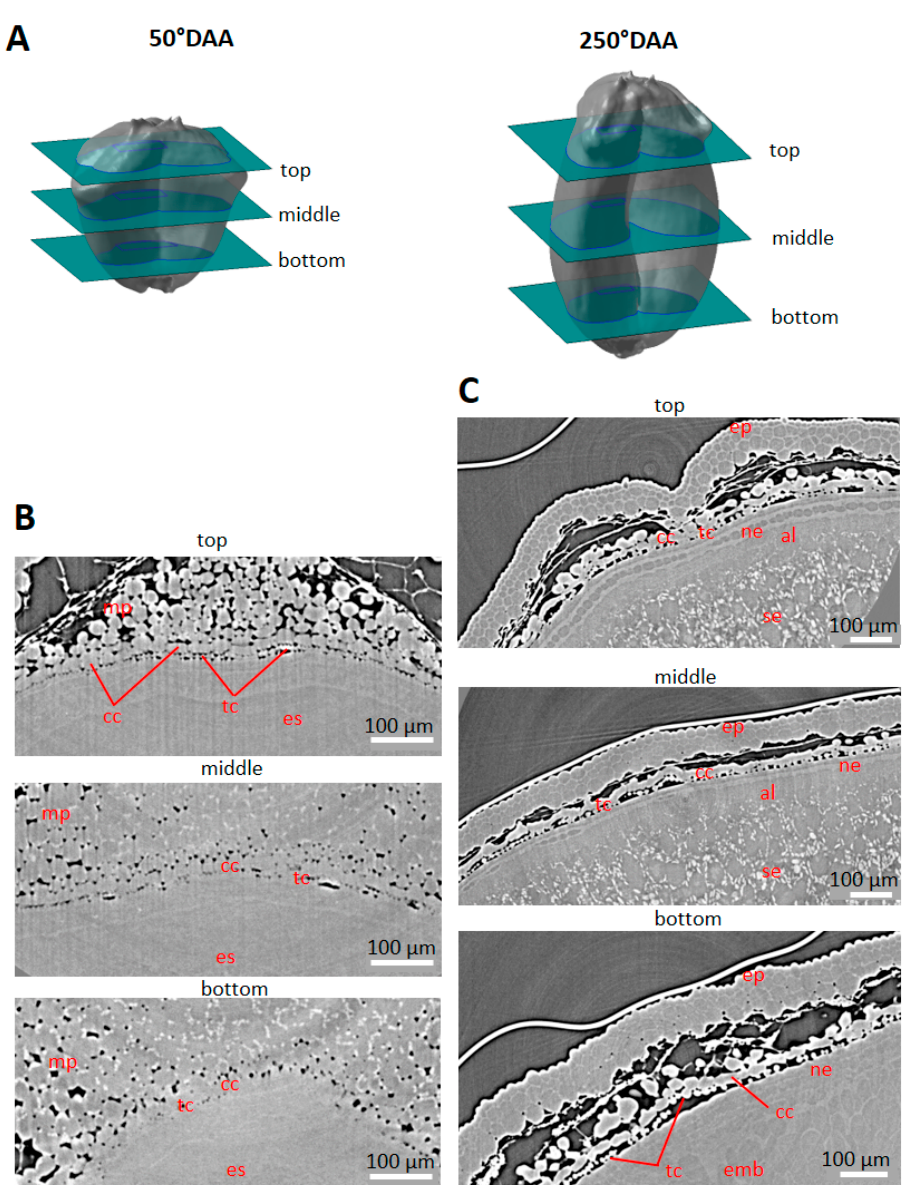
Figure 3. Spatial and developmental variability observed along the caryopsis longitudinal axis. ( A ) Localization of the virtual sections (green) and shown regions (blue rectangles) from high-resolution X-ray µCT. ( B ) Representative image in three regions of a wheat grain harvested at 50 °DAA (dorsal area). ( C ) Representative image in three regions of a wheat grain harvested at 250 °DAA (dorsal area). Legends: mp—mesocarp; cc—cross cells; tc—tube cells; ep—epicarp; se—endosperm; emb— embryo; ne—nucellar epidermis; al—aleurone; es—embryo sac.